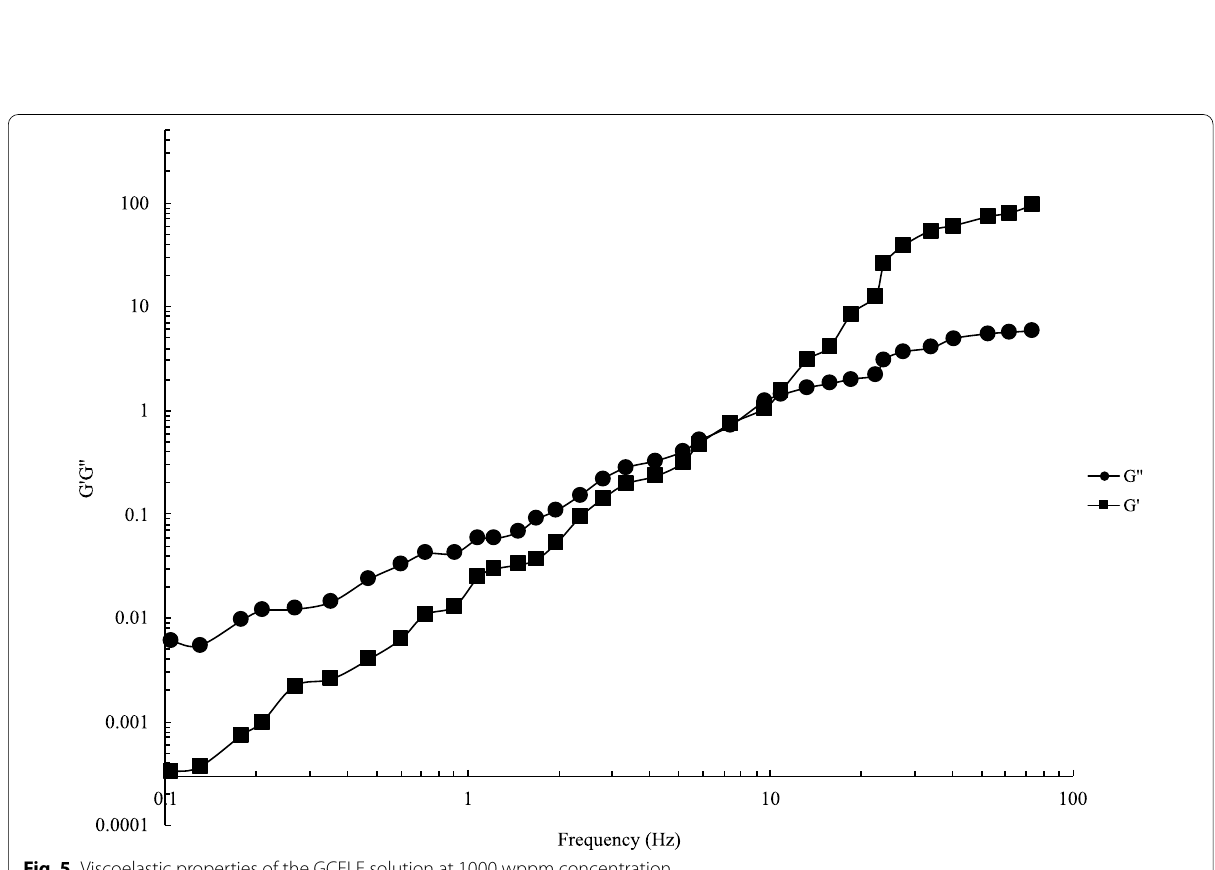
Fig. 5 Viscoelastic properties of the GCELE solution at 1000 wppm